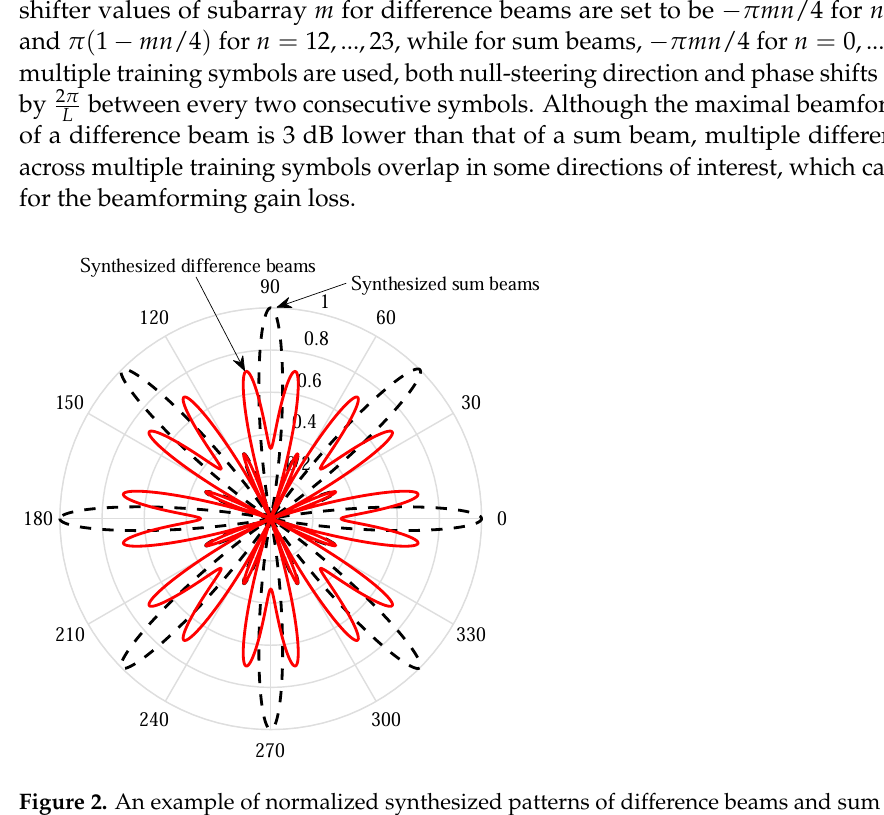
Figure 2. An example of normalized synthesized patterns of difference beams and sum